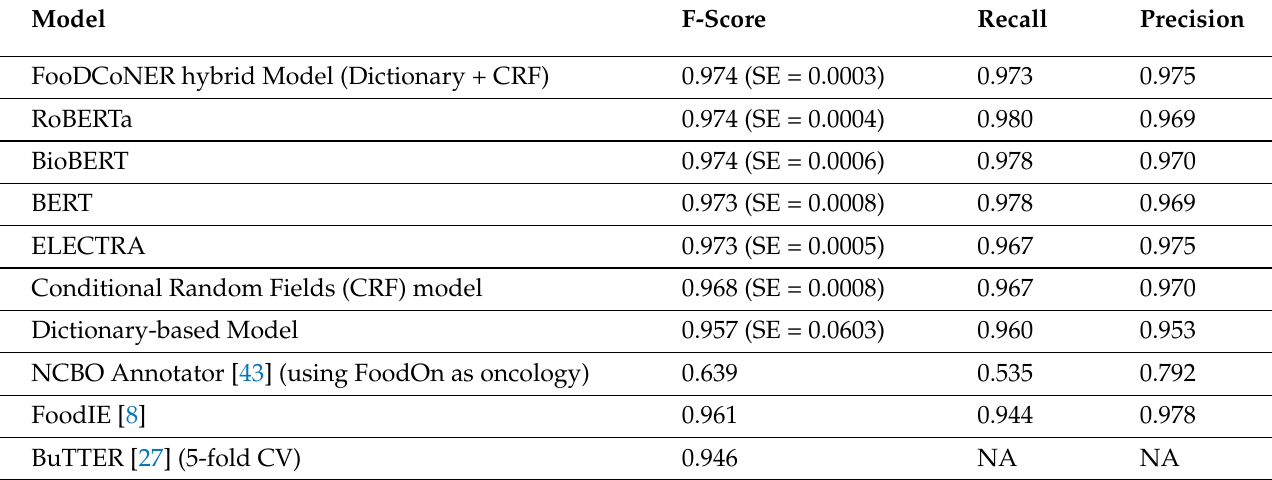
Table 5. Comparison of F-score, precision and recall for (i) hybrid model FooDCoNER, (ii) RoBERTa, (iii) BioBERT, (iv) BERT, (v) ELECTRA, (vi) conditional random fields model and (vii)